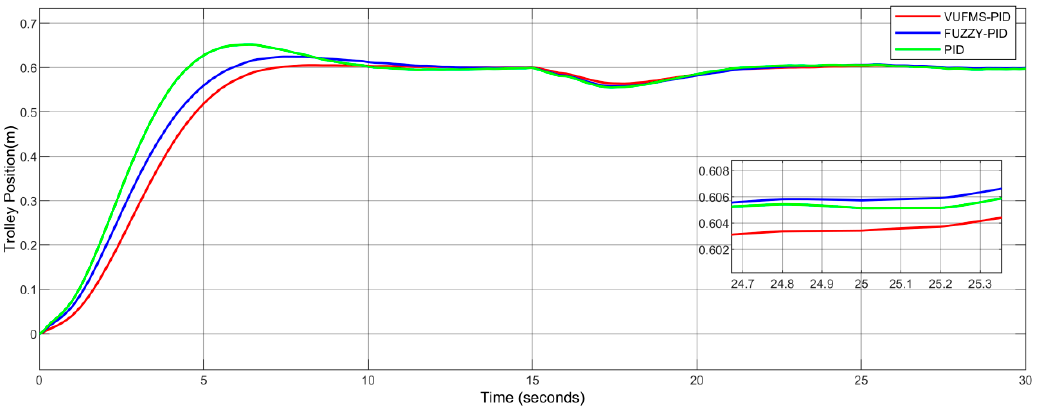
Figure 18. Payload’s swing angle using VUFMS-PID, FUZZY-PID and PID controller under working condition 2 with a crosswind and white noise.